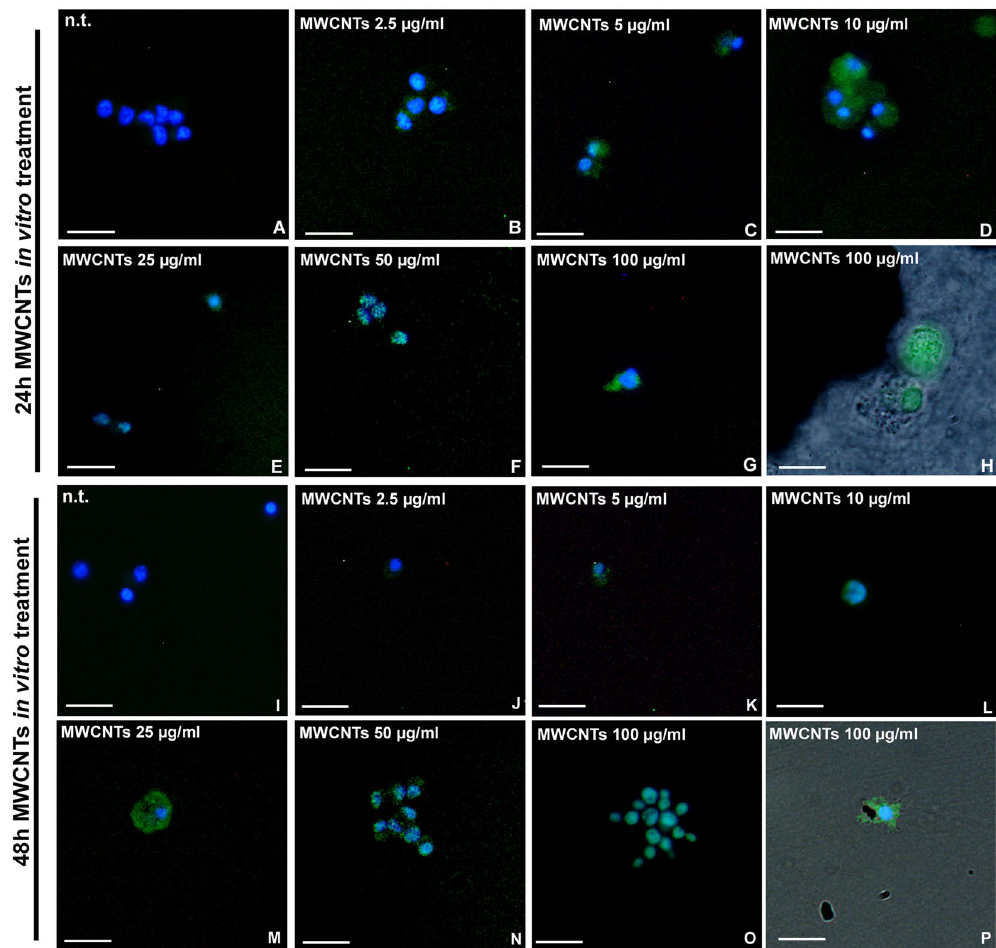
Figure 7. H 2 DCFH-DA assay for ROS detection ( A – P ). H 2 DCFH-DA positivity (green) is not visible in n.t. macrophages at 24 h ( A ). After 24 h in vitro treatment with increasing concentration of MWCNTs a strong positivity is detectable ( C – H ). The same dose-dependent ROS production is appreciable after 48 h from treatment ( J – P ). Combined optical and fluorescence details showing H2DCFDA + cells close to MWCNT bundles ( H , P ). Bars in ( A – P ) 10 µ